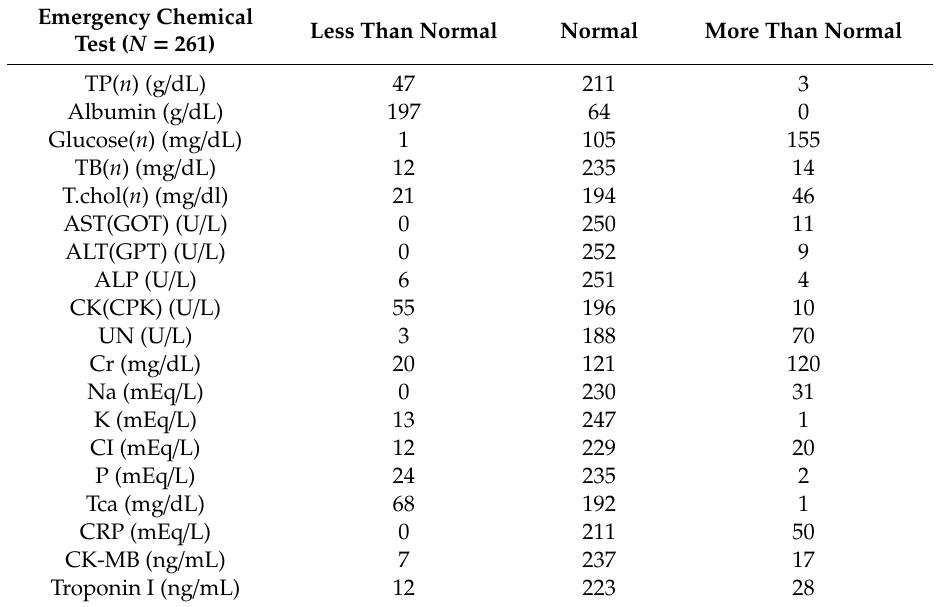
Table 4. Characteristics of the emergency chemical test.